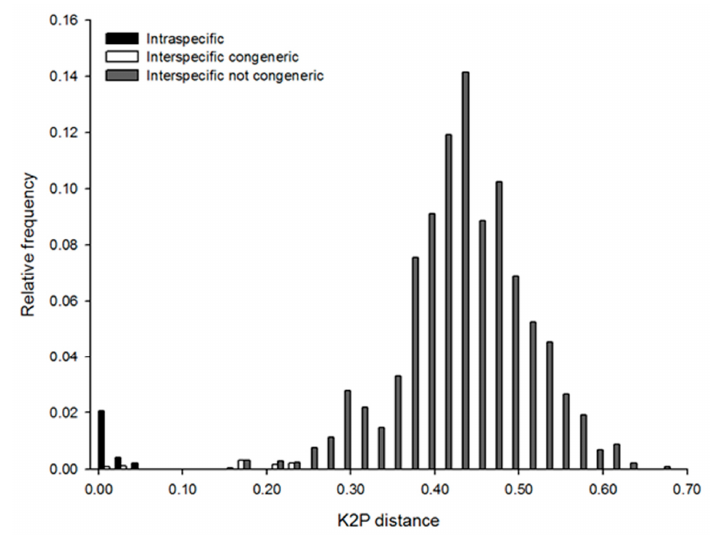
Figure 4. Relative frequencies of Kimura two-parameter (K2P) distances in the COI sequences of marine nematodes analyzed in this study. Frequencies within species are marked in black, among congeneric species in white, and between species from different genera in grey.